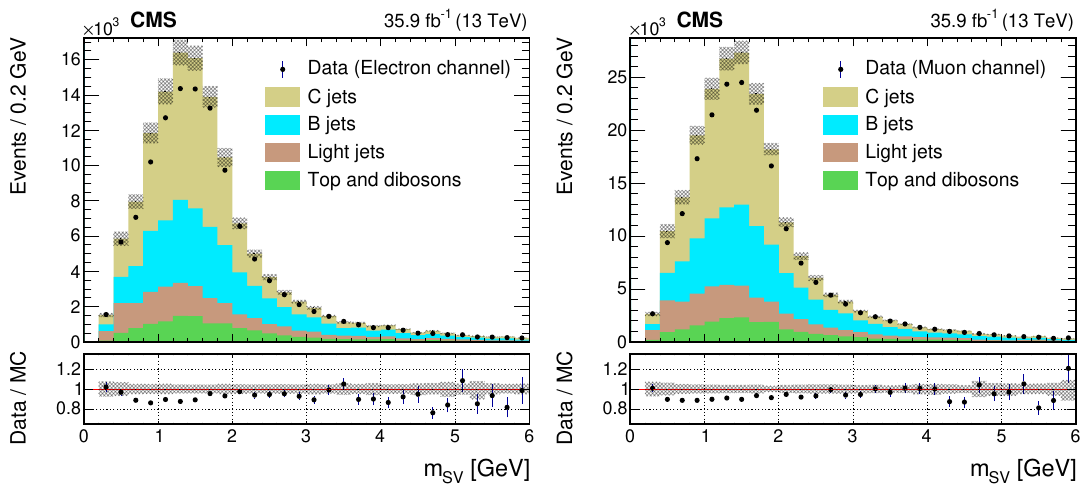
of the highest- p c -tagged central jet, SV T